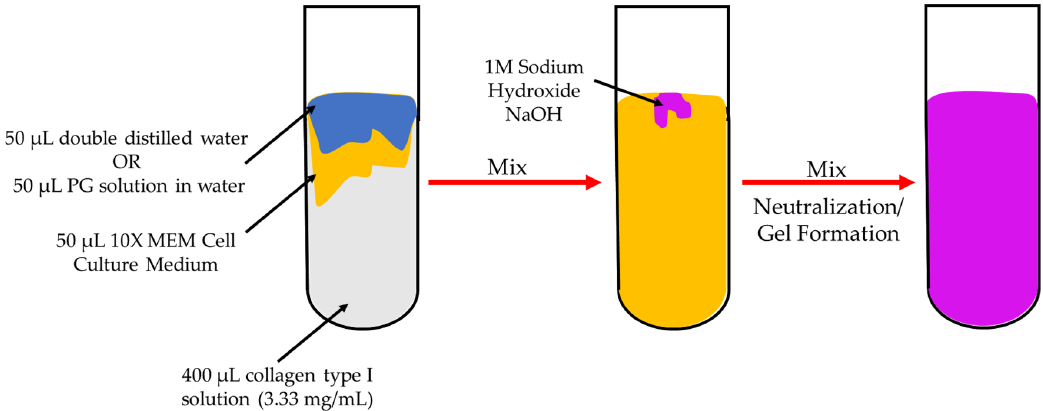
Figure 7. Diagram of preparation of collagen hydrogels. Collagen hydrogels were prepared by mixing 50 µ L of double distilled water or 50 µ L PG solution in water with 50 µ L 10X MEM Cell Culture Medium and 400 µ L of collagen type I solution (3.33 mg / mL). Then, with the neutralization of the solution by adding some drops of 1M NaOH solution, the solution became violet and hydrogels formed. Table 1. Collagen hydrogels composition.